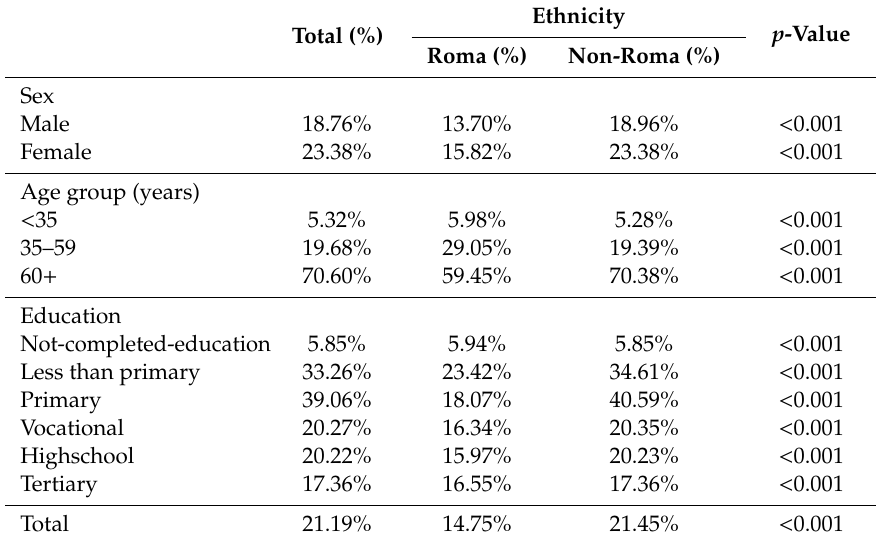
Table A2. Chronic disease prevalence of the study population and the di ff erences between the Roma and non-Roma populations, evaluated by χ 2